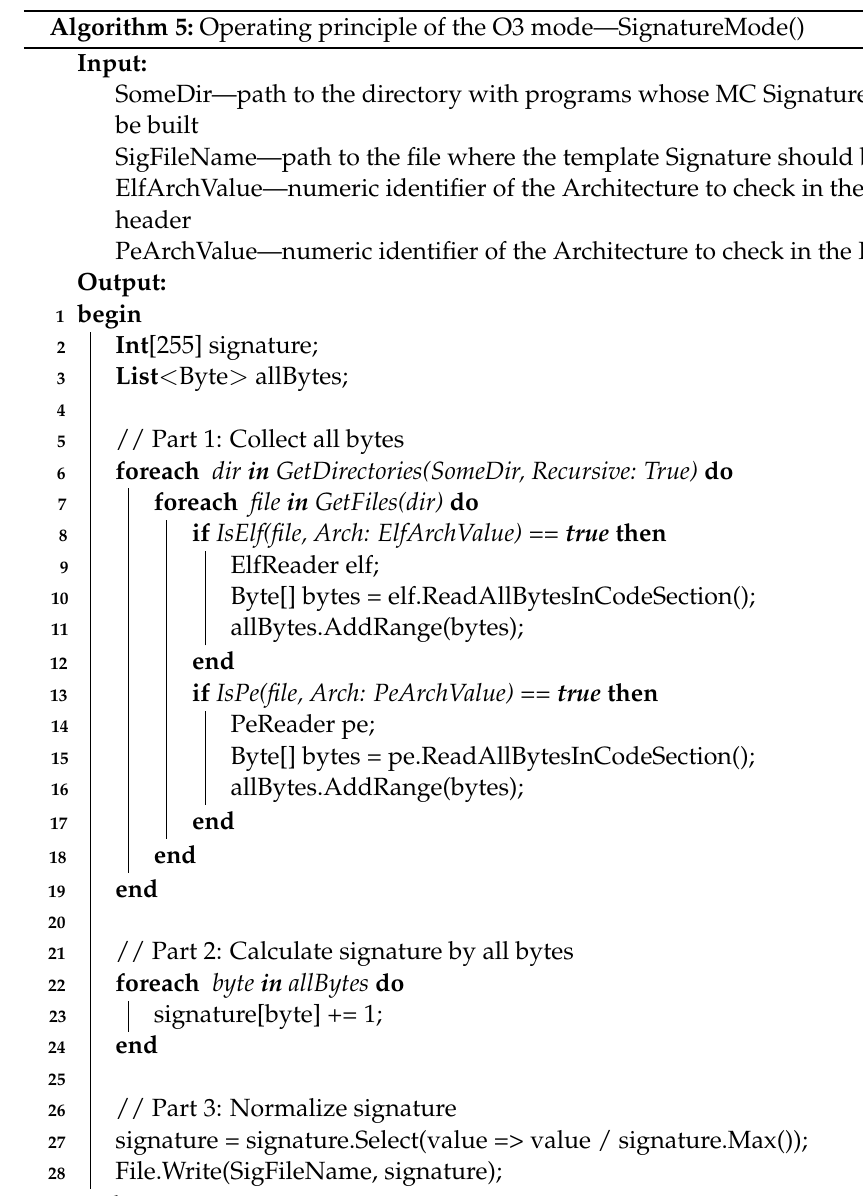
Algorithm 5: Operating principle of the O3